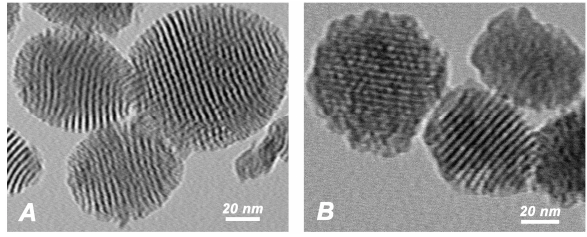
Figure 1. TEM images of ( A ) pMSN; and ( B ) CHX@pMSN.